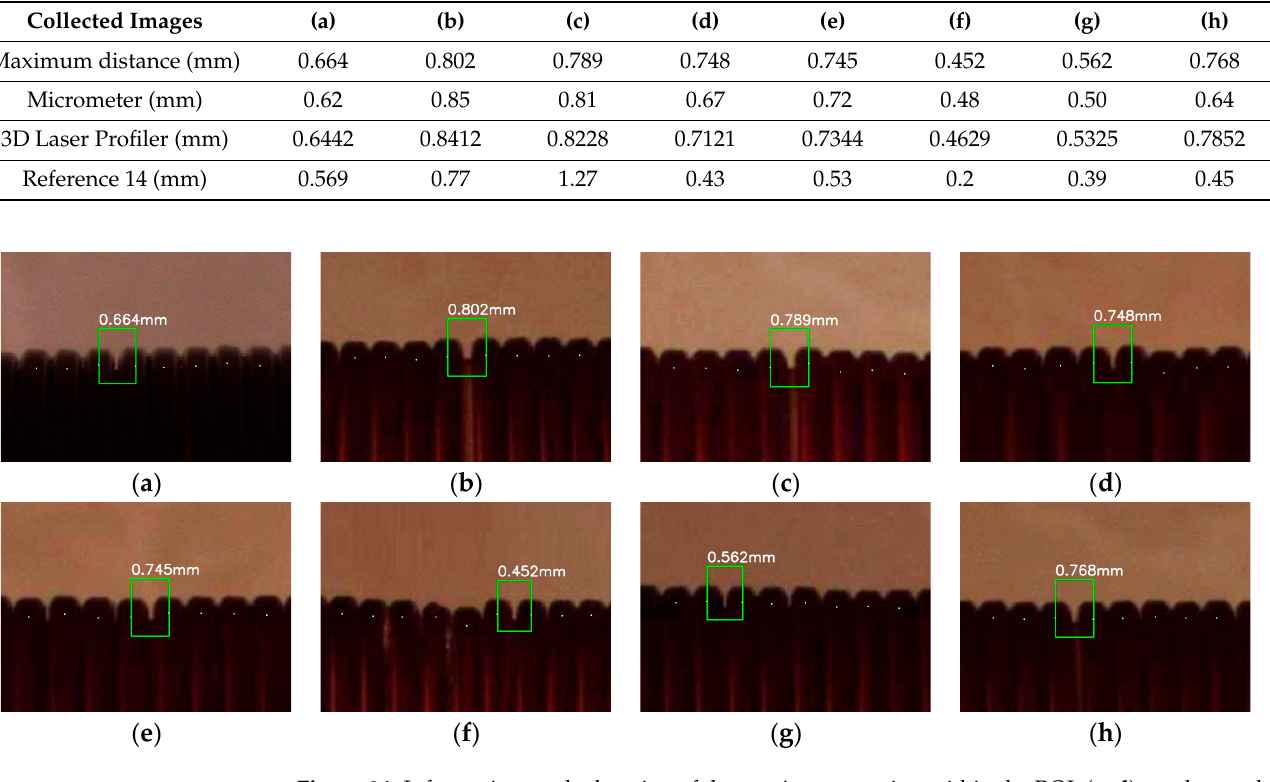
Figure 24. Information on the location of the maximum spacing within the ROI: ( a – d ) are the results of the maximum gap detection result within the ROI of the 2.4 mm wire profile; ( e – h ) are the results of the maximum gap detection result within the ROI of the 2.6 mm wire profile.